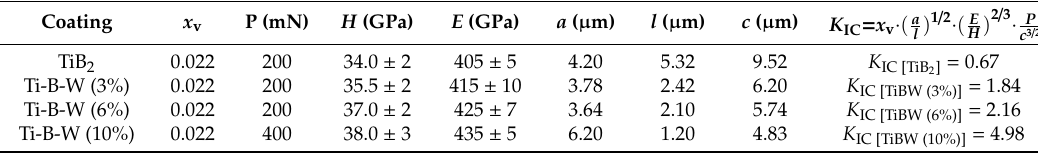
Table 4. Results of calculation of fracture toughness ( K IC ), hardness and Young modulus for all investigated